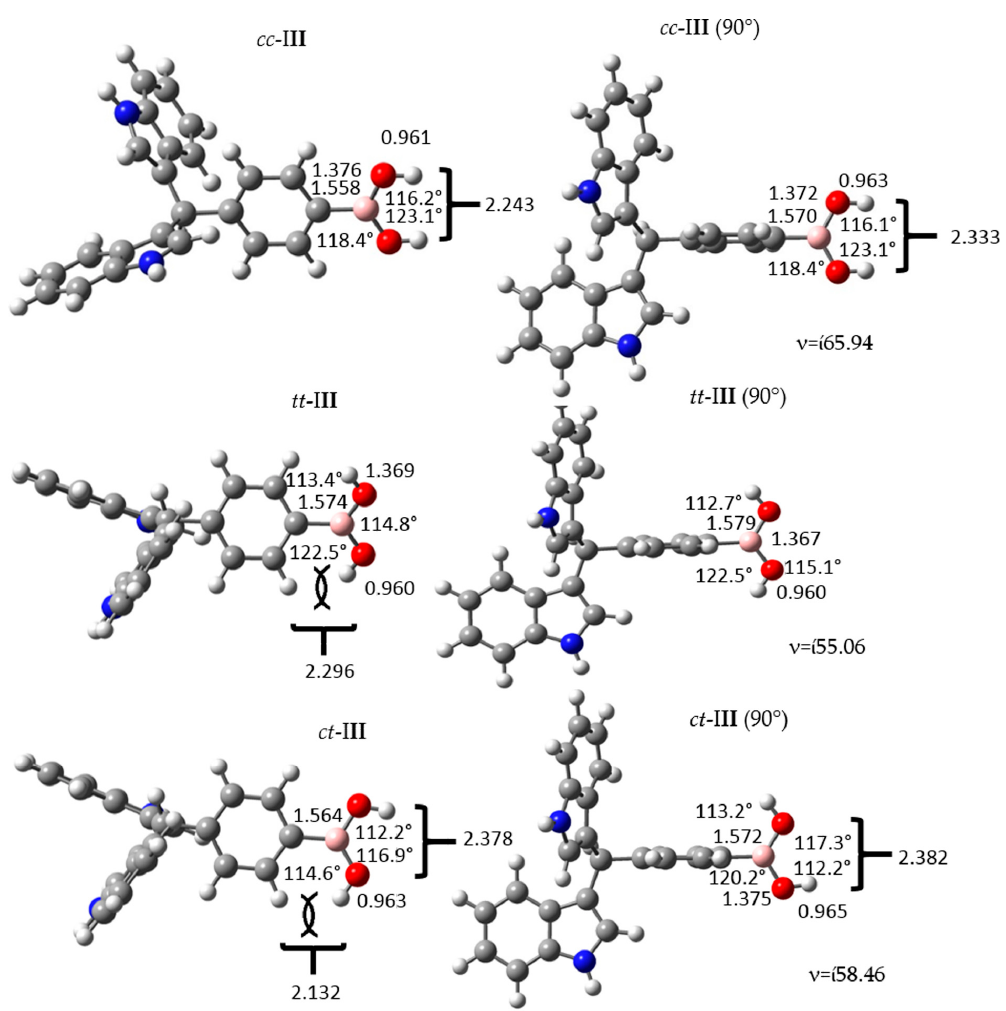
Figure 3. Structure and geometrical parameters of the p -diindolylmethane phenylboronic acid hybrid isomers and their corresponding 90° conformers. The gray, blue, pink, red and white spheres are for carbon, nitrogen, boron, oxygen and hydrogen atoms respectively.